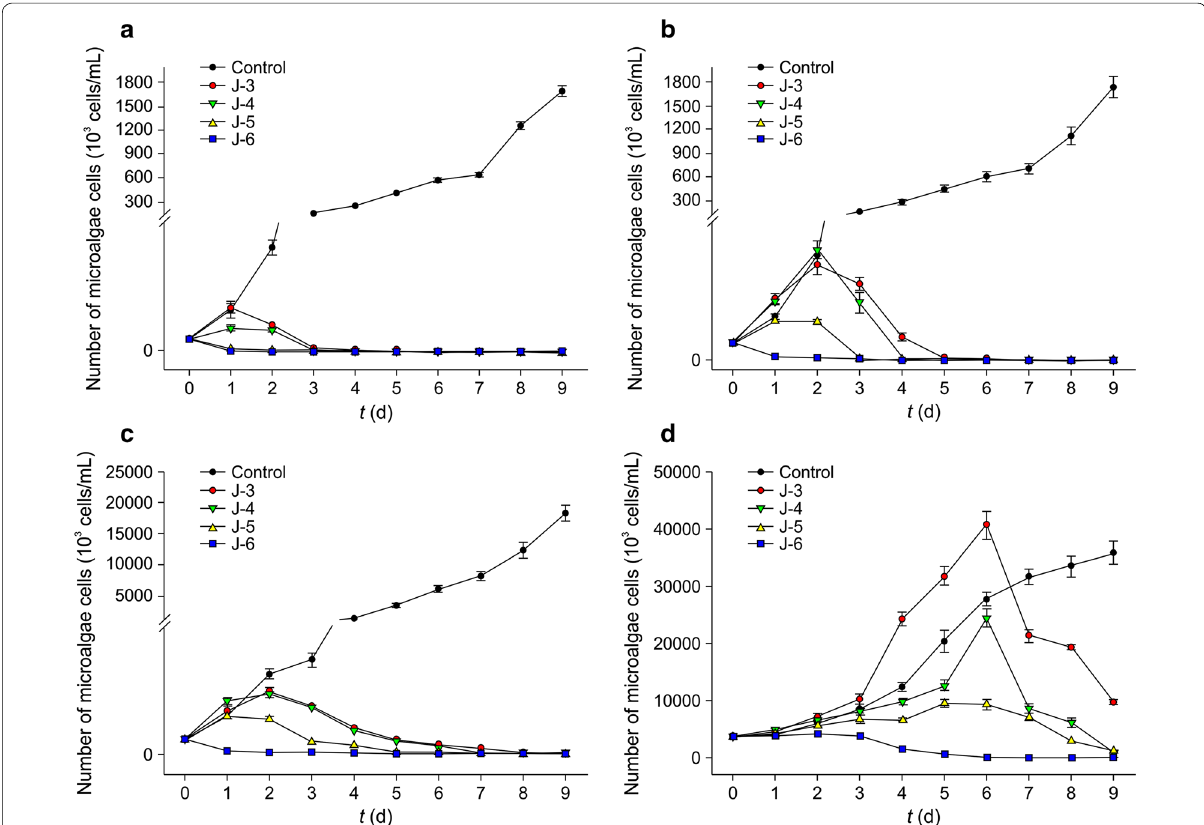
Fig. 7 Alginolytic effects of different initial concentrations of CZBC1 on Oscillatoria chlorina at different initial concentrations. a 10 3 cells/mL. b 10 4 cells/mL. c 10 5 cells/mL. d 10 6